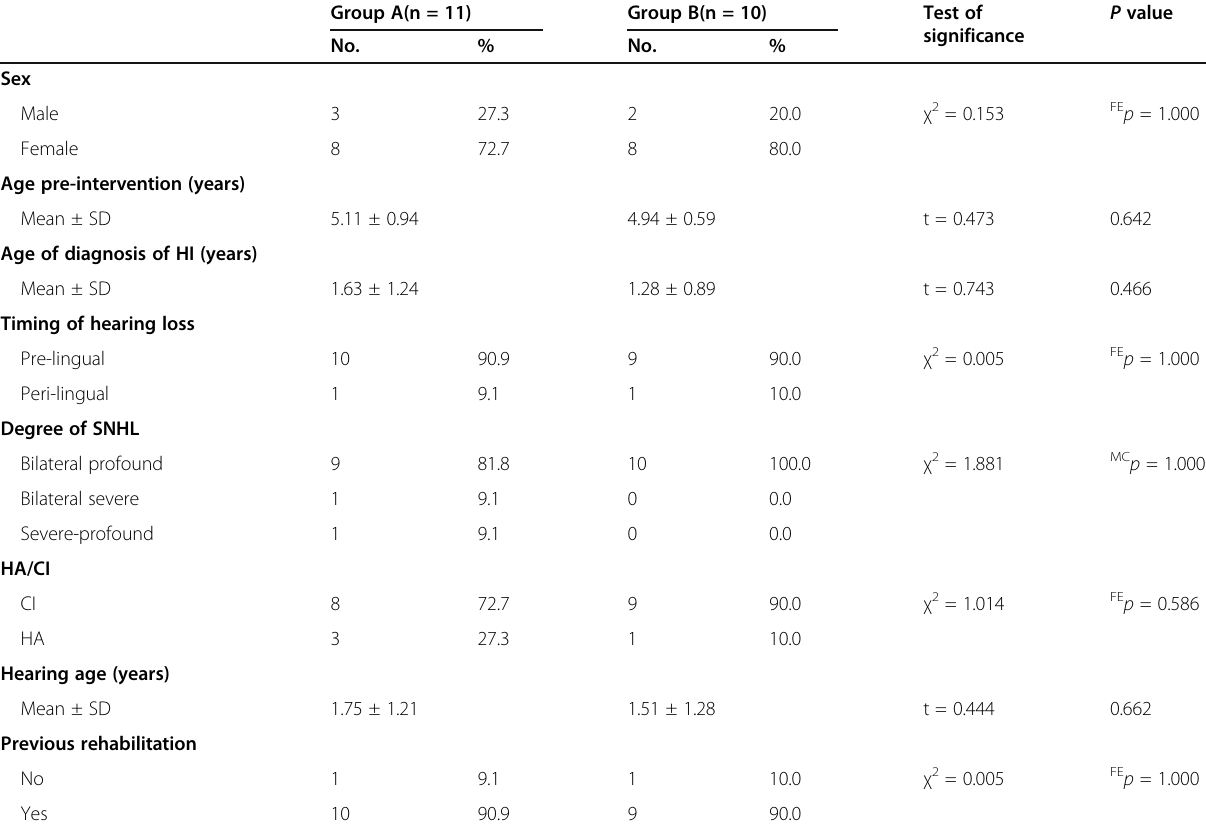
Table 1 Comparison between the two studied groups according to demographic data and history Group A(n =